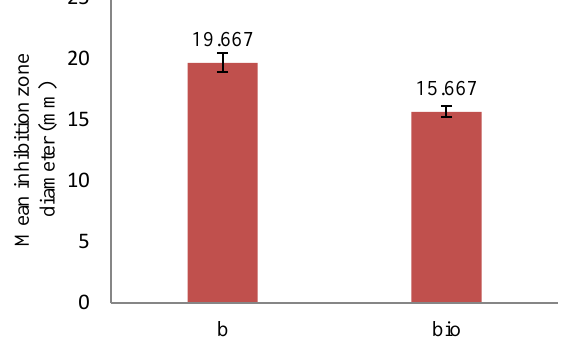
Fig. 9. General diagram of changes in mean growth inhibition zone diameter of P. aeruginosa in free bacterial states and bacterial biofilm